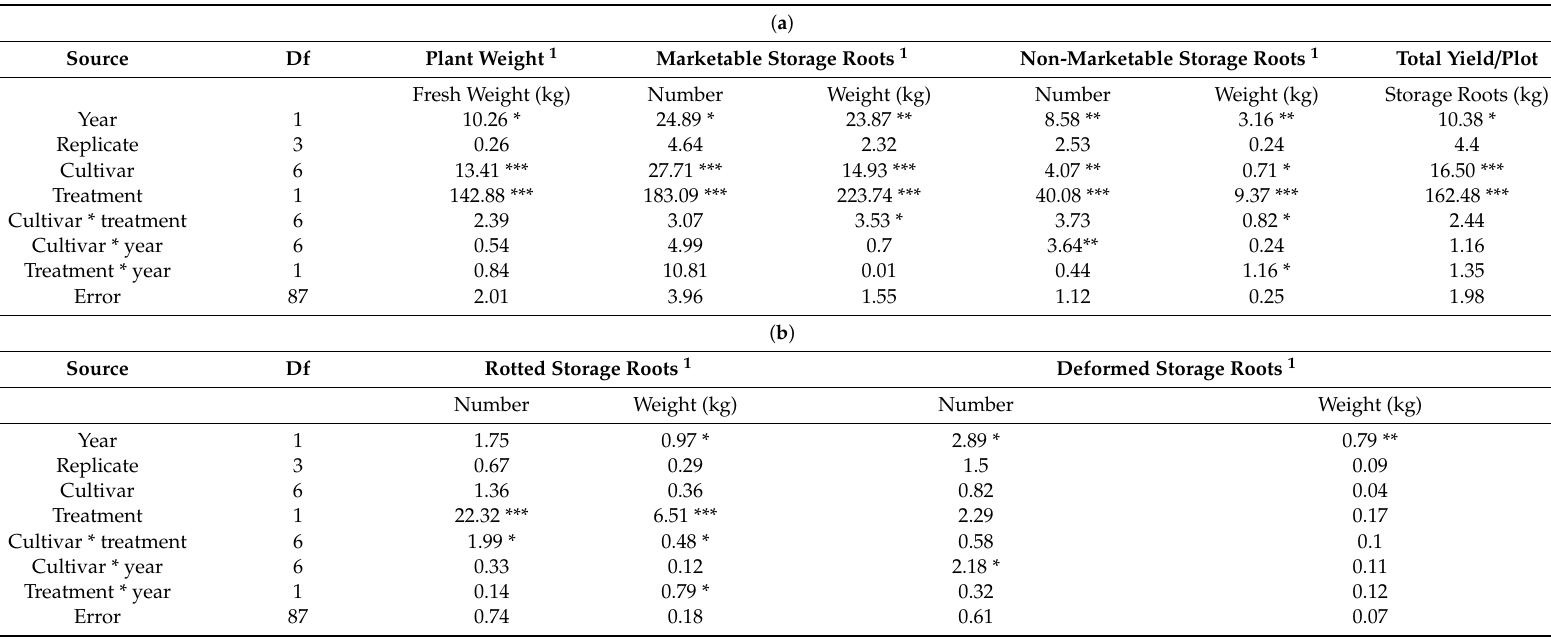
Table 4. ( a ) Mean squares for yield evaluation of six biofortified cassava and one white cultivar in field trials in Nigeria. ( b ) Mean squares for non-marketable yield evaluation of six biofortified cassava and one white cultivar in field trials in Nigeria. ( c ) Yield evaluation of six biofortified cassava cultivars in first field trial in Nigeria 1 . ( d ) Yield evaluation of six biofortified cassava cultivars in second field trial in Nigeria 1 . ( e ) Non-marketable yield evaluation of six biofortified cassava cultivars in field trials in Nigeria 1